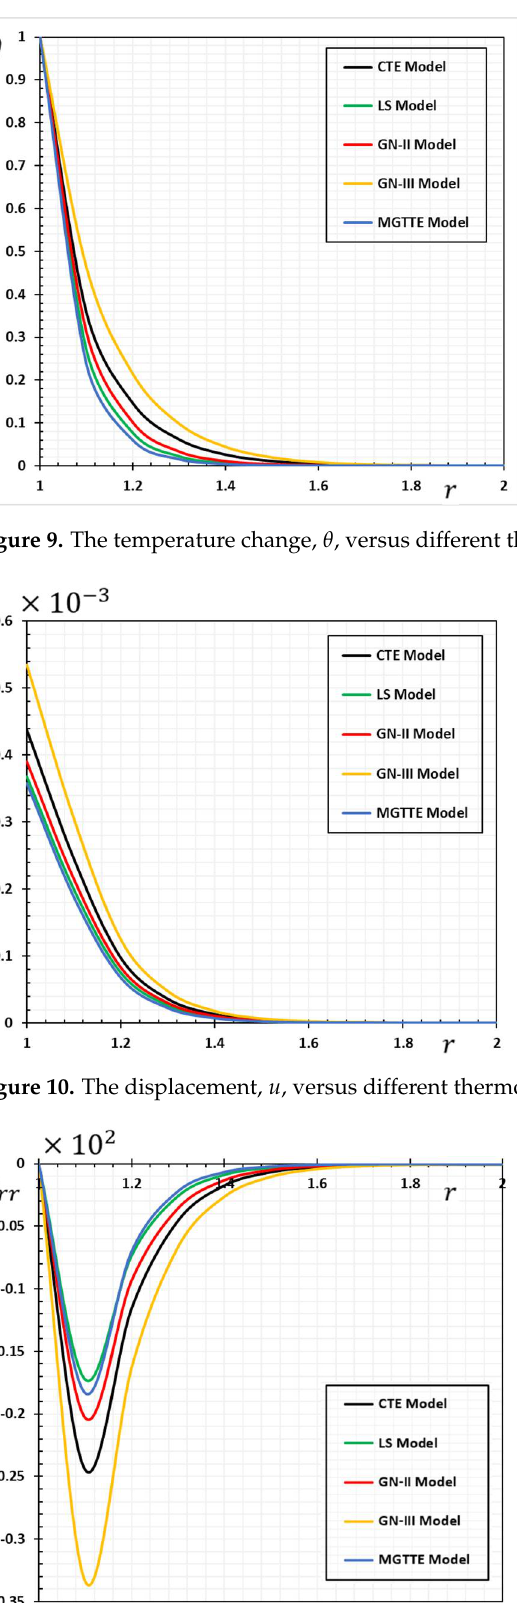
Table 2. The displacement, (cid:1873) , versus different models of thermoelasticity.